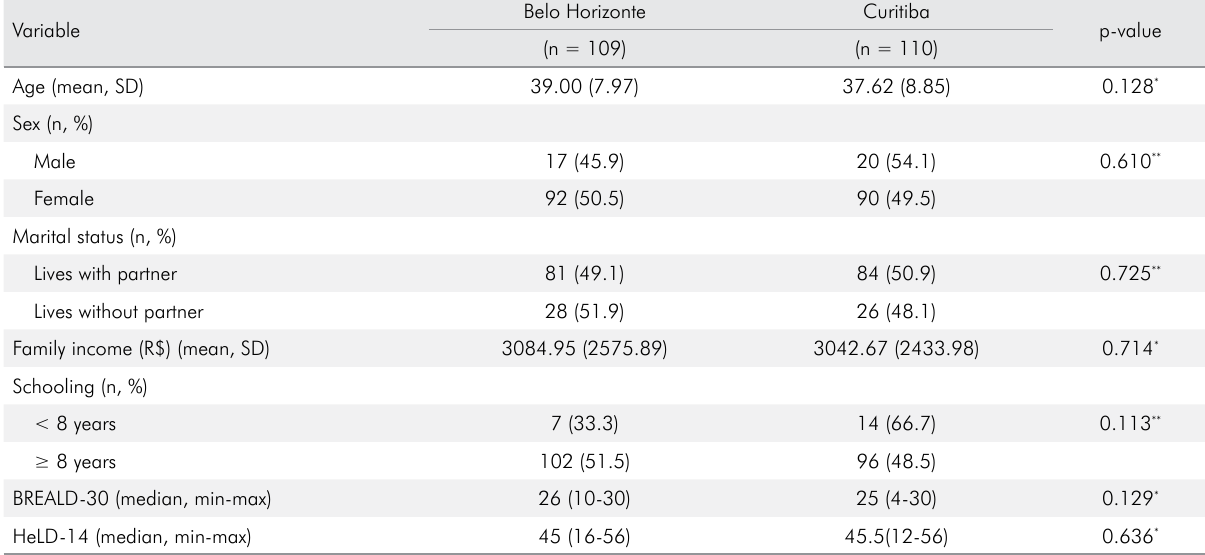
Table 1. Characteristics of the study population (n = 219).